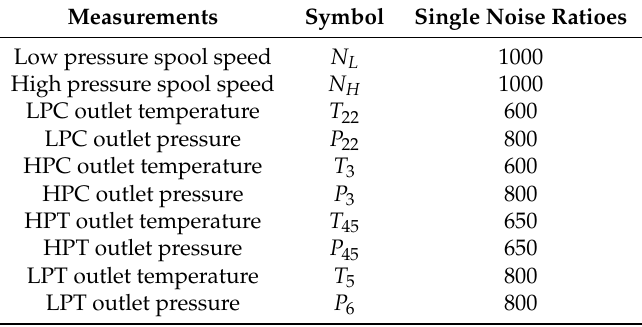
Table 6. Measurements and single noise ratio of one aircraft